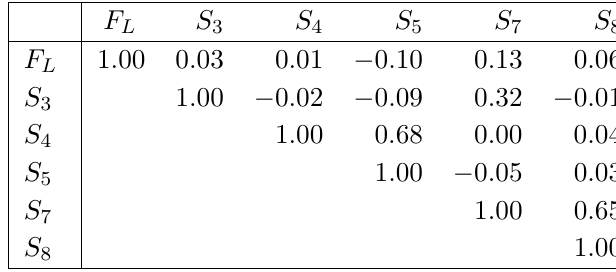
Table 14 . Statistical correlation matrix for the F